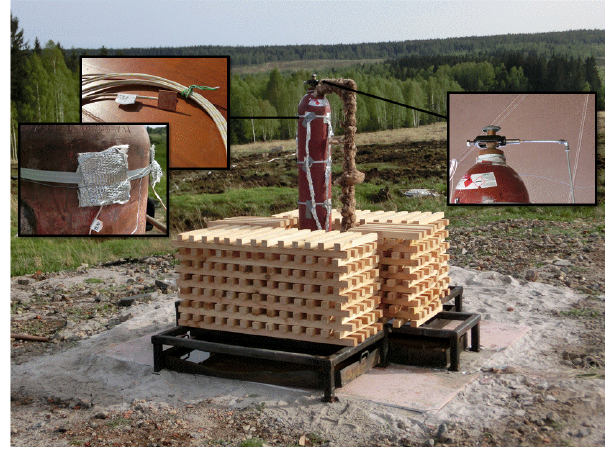
Figure 2. Acetylene cylinder inside prepared woodpile.